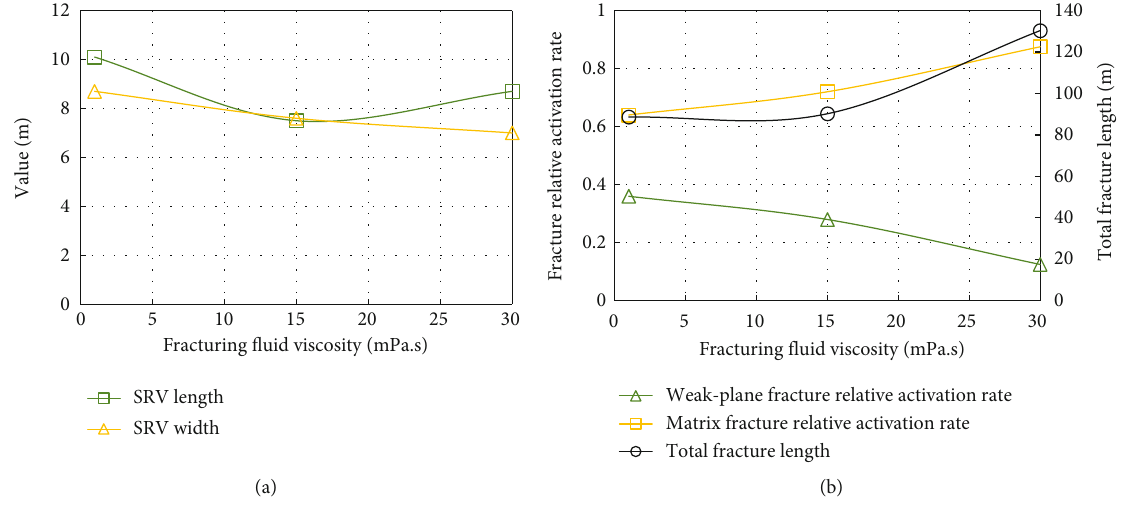
Figure 13: In fl uence of fracturing fl uid viscosity on SRV (a) and relative fracture activation